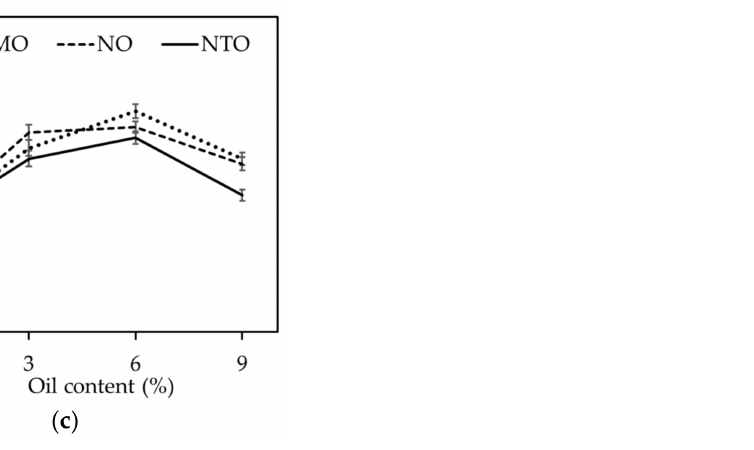
Figure 7. ( a ) 300% modulus and ( b ) elongation at break ( c ) tensile strength of the NRCs comprising different oil types and